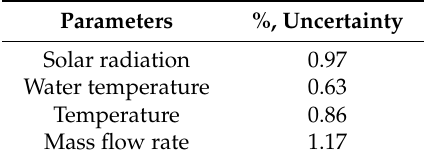
Table 1. Uncertainty values of the experimental set-up.